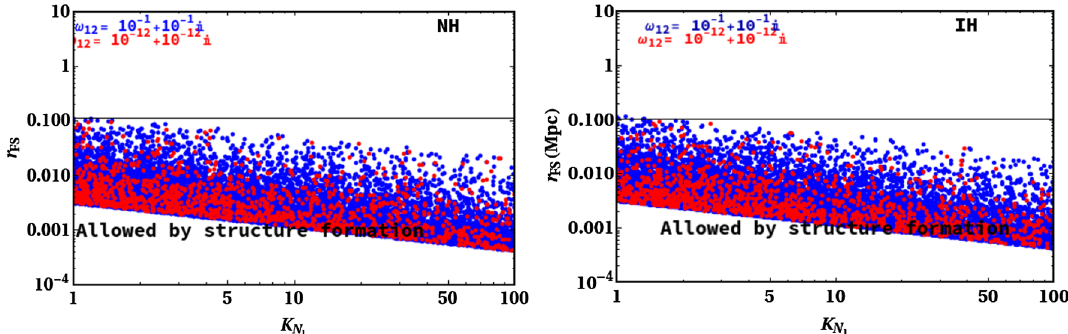
Fig. 10 The plot shows variation of free streaming length w.r.t the decay parameter K N values of arbitrary angle ω